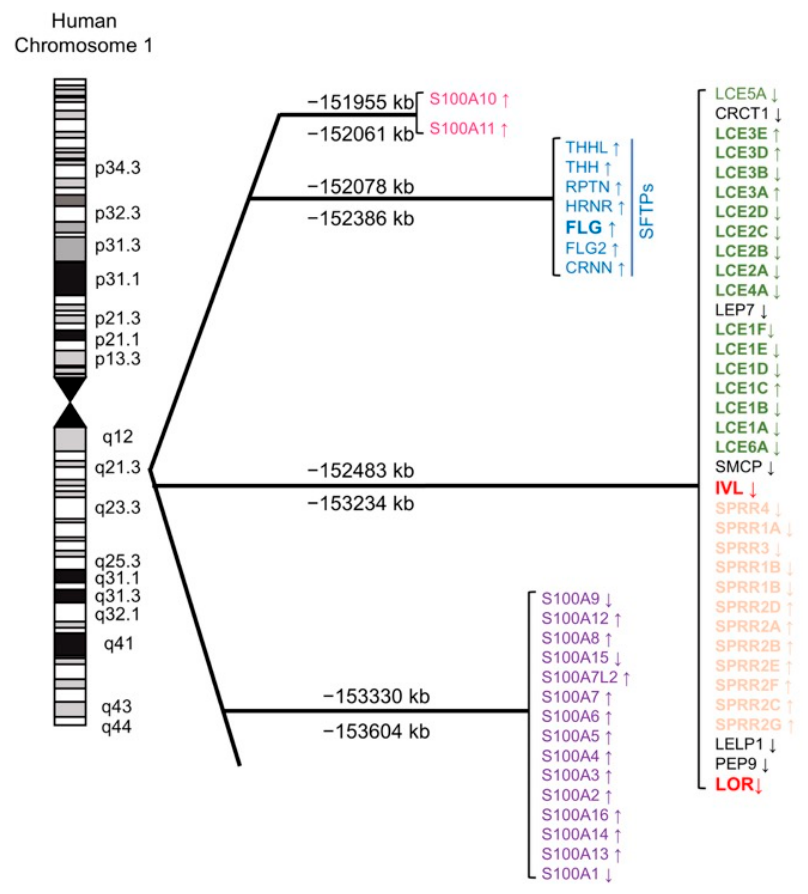
Figure 2. The epidermal differentiation complex (EDC). Schematic representation of human chromosome 1 and the EDC genes, which are thought to have evolved from a common ancestor and constitute diversified subfamilies.